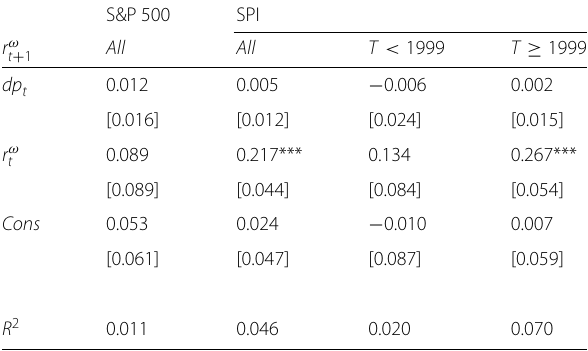
Table 3 Zero-stage regression: equity returns